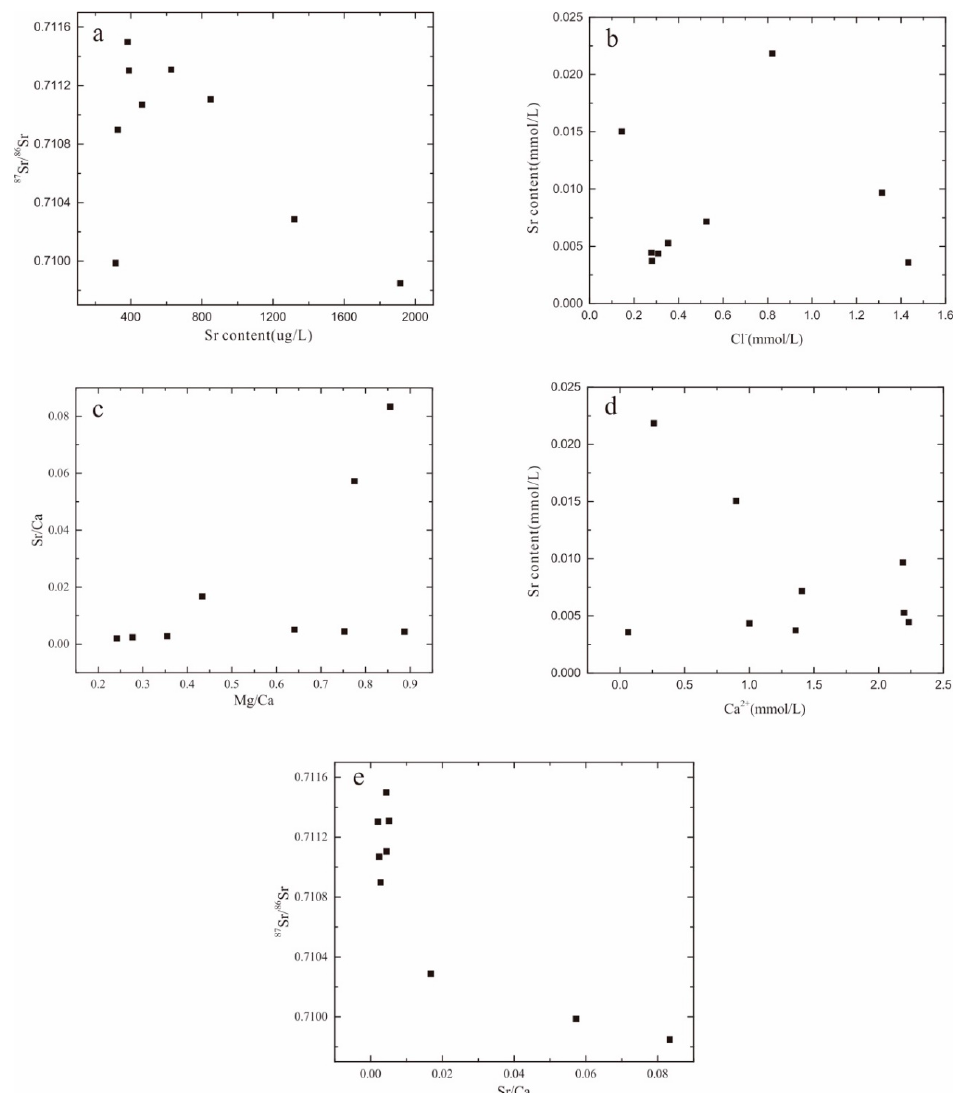
Figure 7. Relationships among Sr concentrations, Sr isotopes, and other ion concentrations of groundwater ( a – e ).